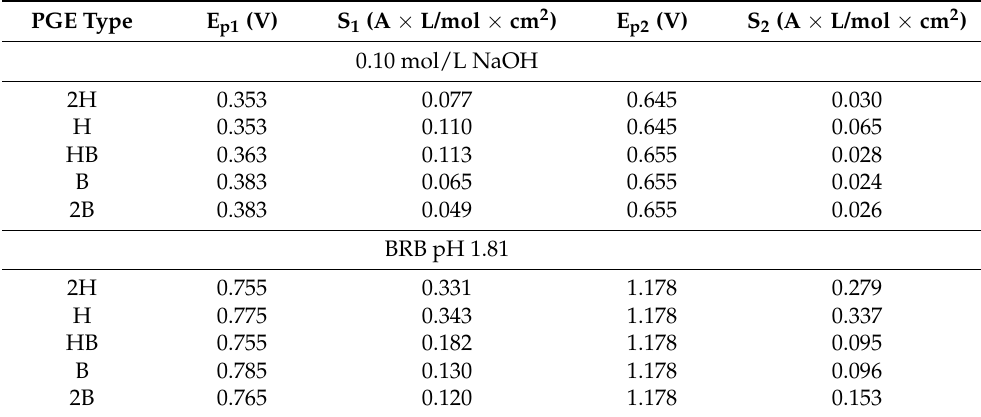
Figure 2. Differential pulse voltammograms recorded on different working electrodes for 1.89 × 10 − 4 mol/L DIO in 0.10 mol/L NaOH. Table 1. Peak potentials and sensitivities of DIO oxidation signals obtained by DPV on PGEs with different hardnesses.